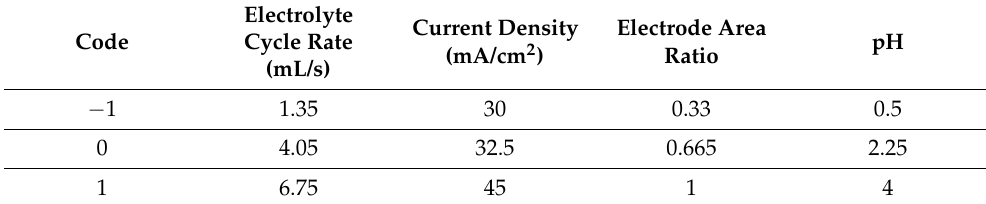
Table 3. The experimental factors and level